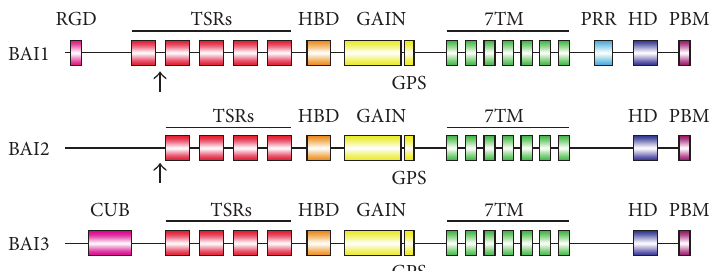
Figure 1: Schematic representation of BAI family members. BAI adhesion-GPCRs have a diverse collection of signaling and structural domains. These include thrombospondin type I repeats (TSRs), a hormone binding domain (HBD), the GAIN domain (GAIN), the GPCR autoproteolysis site (GPS), the characteristic seven-transmembrane domain (7TM), an 𝛼 -helical RKR motif (HD), and the PDZ-binding motif (PBM), which are shared between all three family members. BAI1 has five TSRs, while BAI2 and BAI3 only have four. BAI1 and BAI2 are cleaved by proteases (BAI1 by matrix metalloprotease-14, BAI2 by Furin), which generates truncated fragments at the indicated locations marked by arrows. BAI1 has an additional integrin-binding RGD motif in the N-terminus and a proline-rich region (PRR) in the C-terminus. BAI1 also has a slightly truncated third intracellular loop compared to the other family members. BAI3 has a unique CUB domain in the